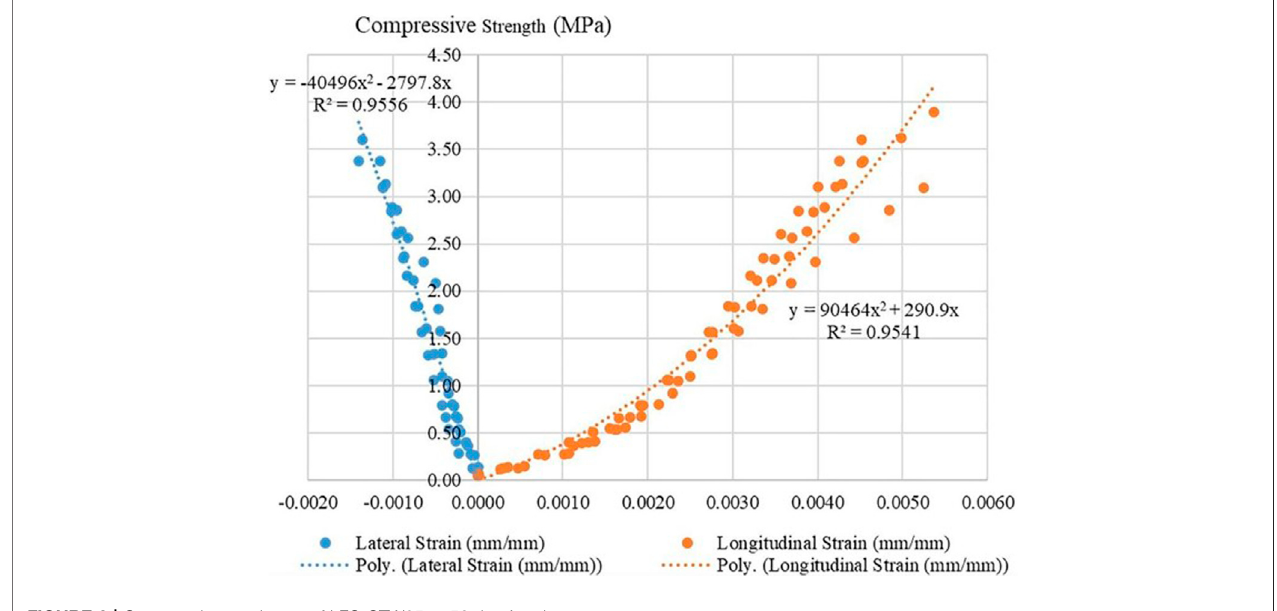
FIGURE 9 | Compressive toughness of LFC-CTW25 at 56 days ’ curing age.